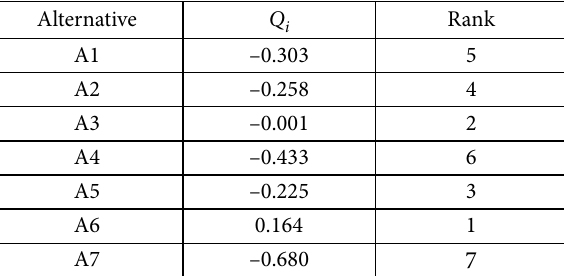
Table 10. Criterion functions and ranking of the alternatives